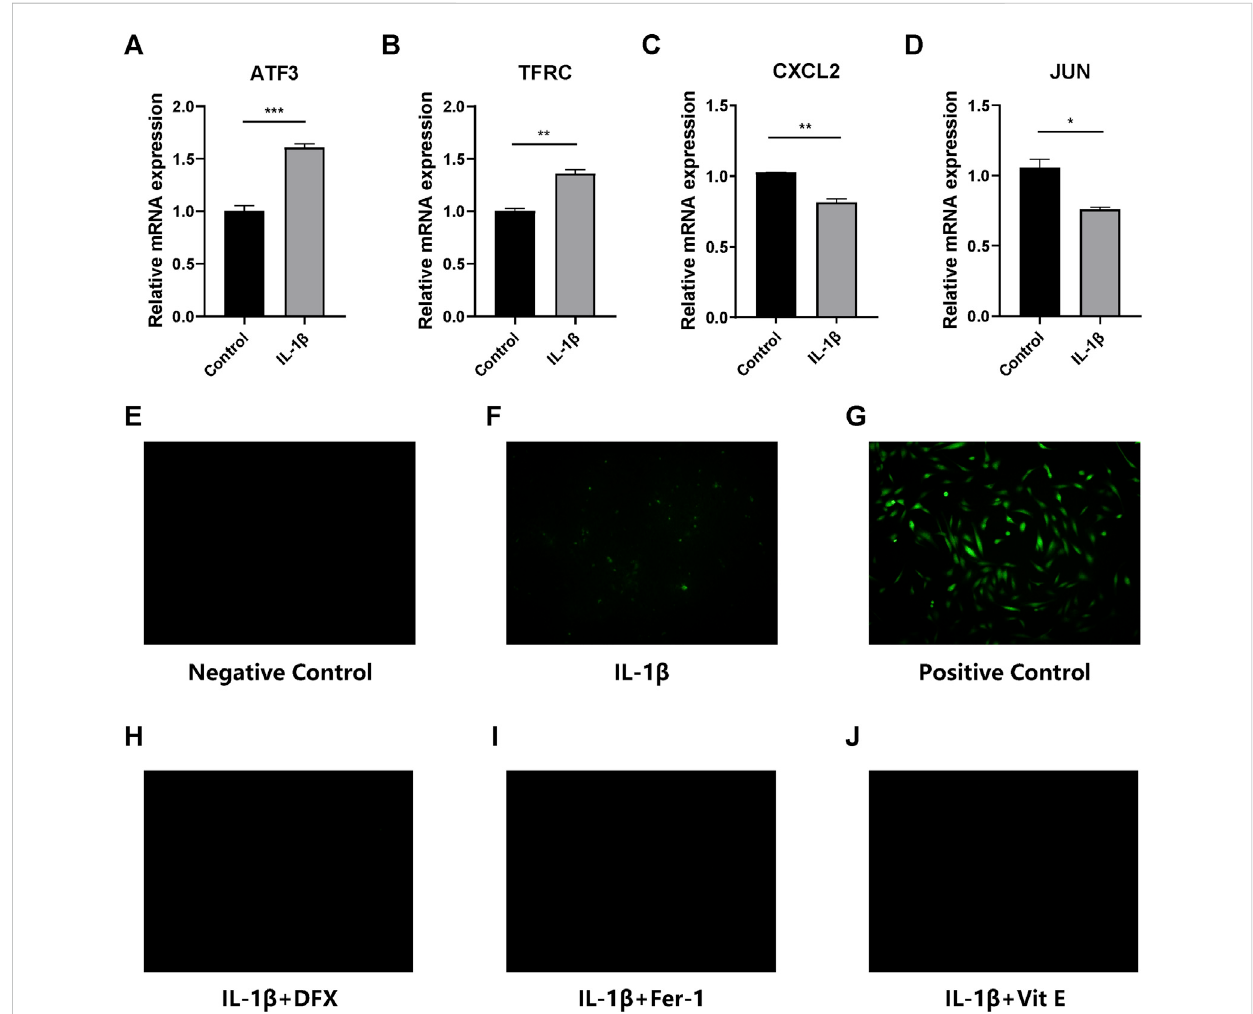
FIGURE 5 (A – D) Quantitative real-time PCR analyses of ATF3, TFRC, CXCL2 and JUN. * p < 0.05; ** p < 0.01; *** p < 0.001. (E – J) ROS detection of the